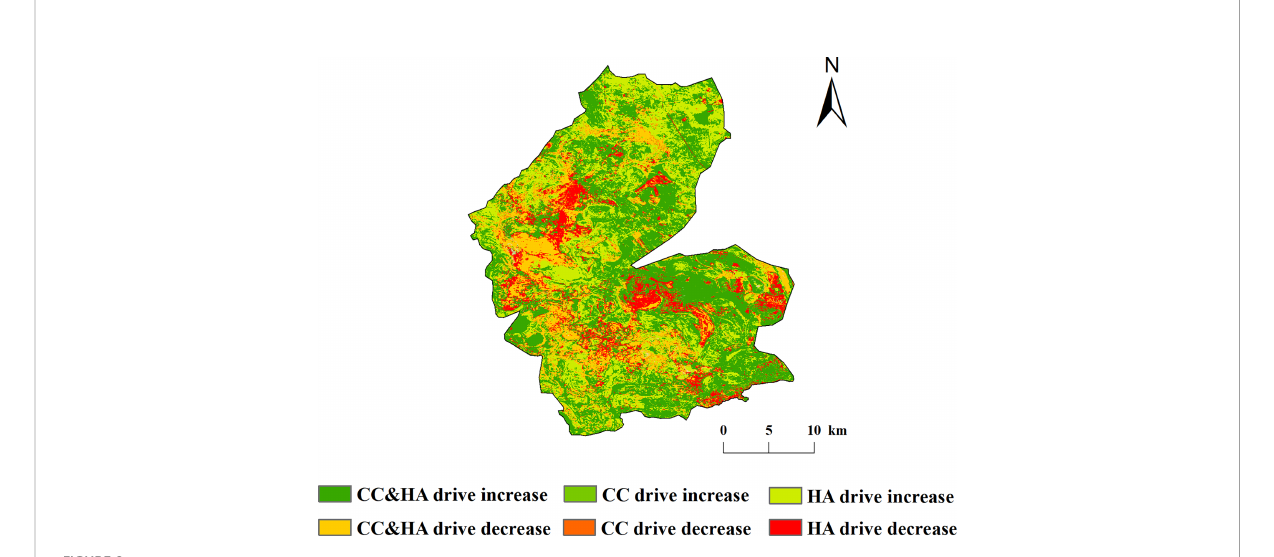
FIGURE 9 Spatial distribution of driving mechanisms of vegetation NDVI change in the study